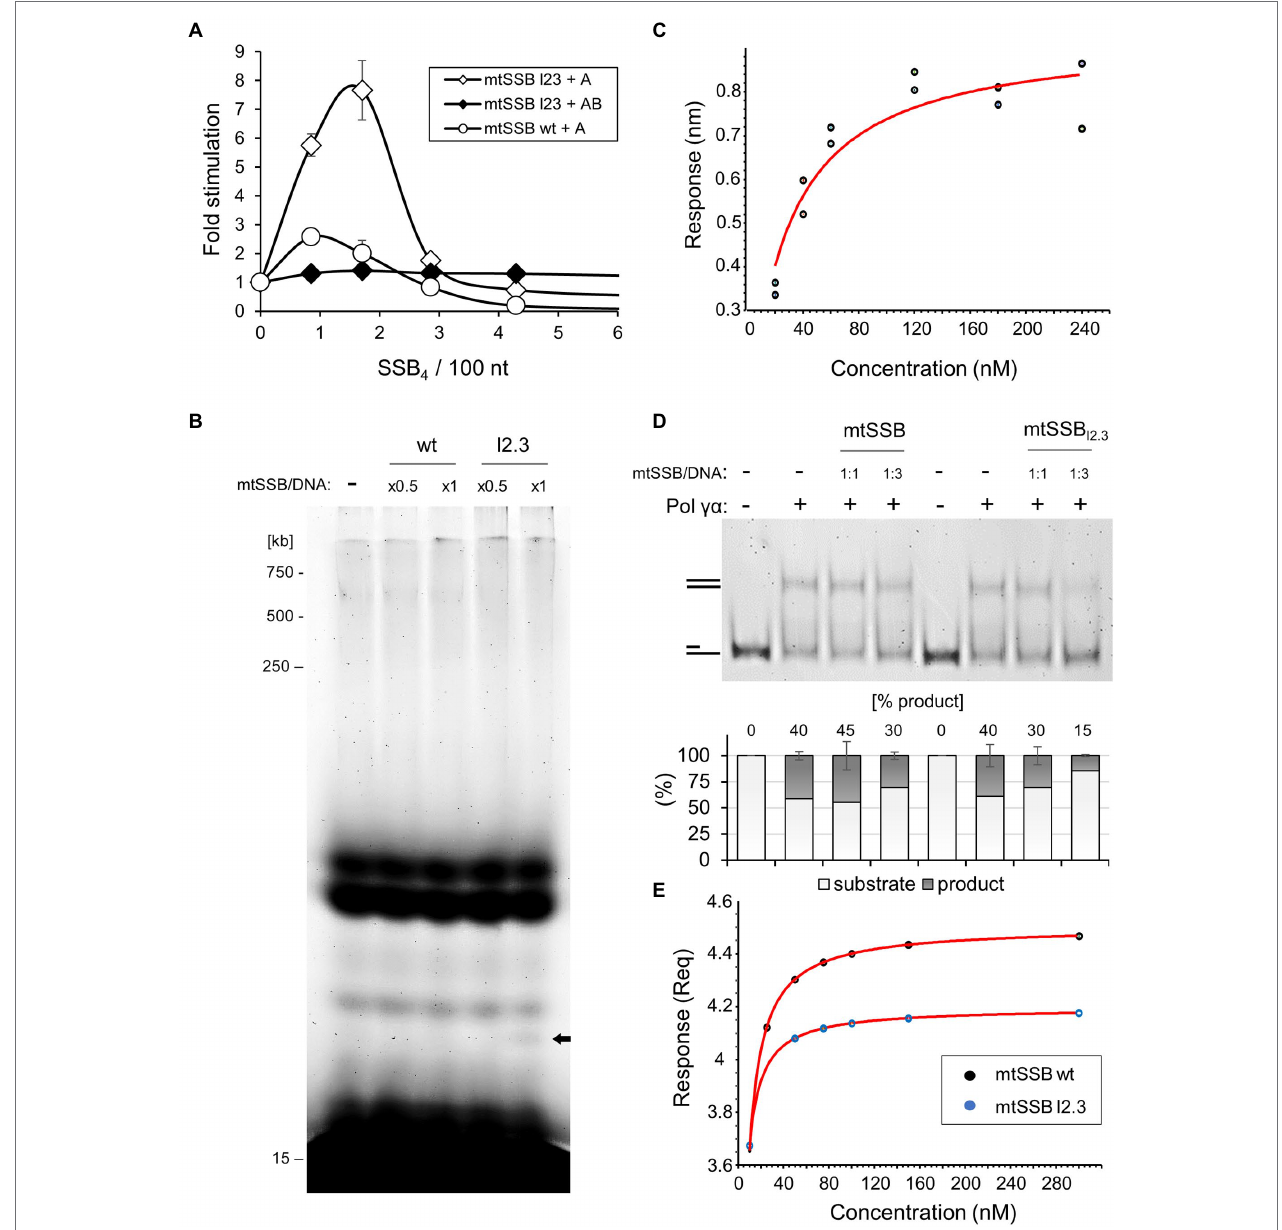
FIGURE 4 | The lack of loop 2.3 impedes the ability of Pol γ to displace mtSSB. (A) The processive DNA synthesis assay was performed as described in Figure 3A except that the mtSSB l2.3 variant was used instead of the wild-type mtSSB where indicated. (B) The processivity assay was performed as described under Materials and Methods, using singly-primed M13 DNA, Pol γα , and increasing concentrations of the wild-type or mtSSB l2.3 variant, at the indicated molar ratios to available binding sites on the DNA substrate (mtSSB/DNA). Products of reactions were analyzed by denaturing polyacrylamide gel electrophoresis. (C) The binding affinity of mtSSB l2.3 for Pol γα was determined by BLI, as described in Figure 2B , using two sets of association responses upon increasing Pol γα concentrations (indicated), fitted to a 1:1 binding model. (D) The ability of Pol γα to displace wild-type or loop2.3-deficient mtSSB was assessed by primer extension assay on a primer-template (15/59) DNA substrate, at the indicated molar ratio of mtSSB variant to available binding sites on the DNA substrate (mtSSB/DNA). The products were analyzed by native polyacrylamide gel electrophoresis. The relative abundance of the fully double-stranded product was estimated by densitometry and the mean of three independent experiments (±SD) is presented in the graph below. (E) ssDNA-binding affinity of the wild-type and mtSSB l2.3 variant was measured by biolayer interferometry, as described in Materials and Methods. The association traces indicated a non-1:1 binding and mass transfer interference. The DNA-binding affinities were estimated, therefore, from the equilibrium responses of the mass transfer fits ( Supplementary Figure 5